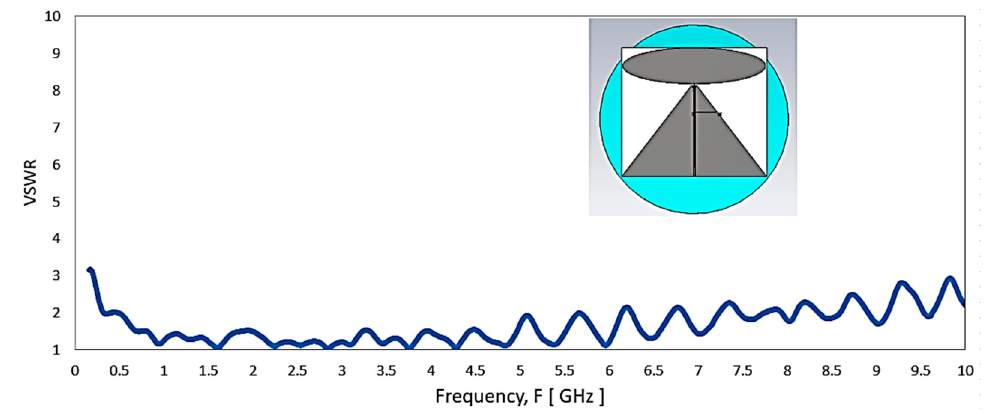
Figure 2. ( a ) Top View and ( b ) Side View of conventional super wideband 2D planar discone (elliptical monopole radiating element with trapezoid ground plane) and tapering coplanar transmission line without adjustment to fit into the small round radome.